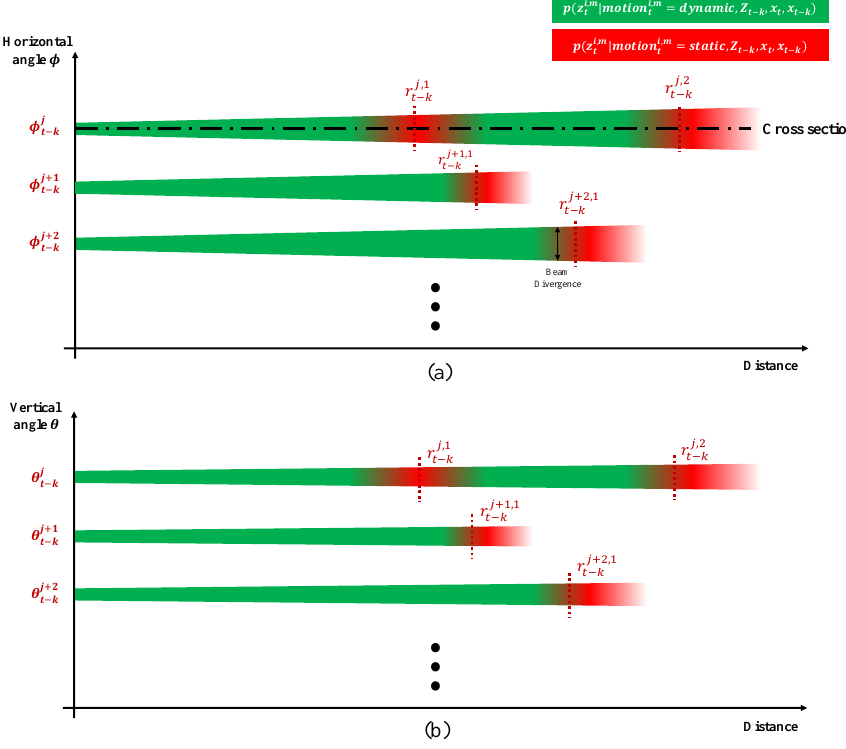
Figure 6. 2D likelihood field for the distance ( r ) and angle (horizontal φ ( a ) and vertical θ ( b )) of the previous measurements z j ,1